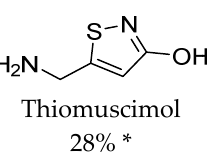
Figure 4. SLC6A6 ligand–thiomuscimol and impact of this GABA analogue on the taurine influx in APRE-19 cells. * Percent of inhibition of taurine uptake in 2 mM screening concentration [68]. In 2022, taurine uptake was tested by TM4–mouse Sertoli cells, which formed a blood–testis barrier [69]. Taurine transport was significantly reduced by β -alanine (95.3% uptake inhibition), hypotaurine (86.7%), GABA (76.7%), and GAA (42.7%). No significant